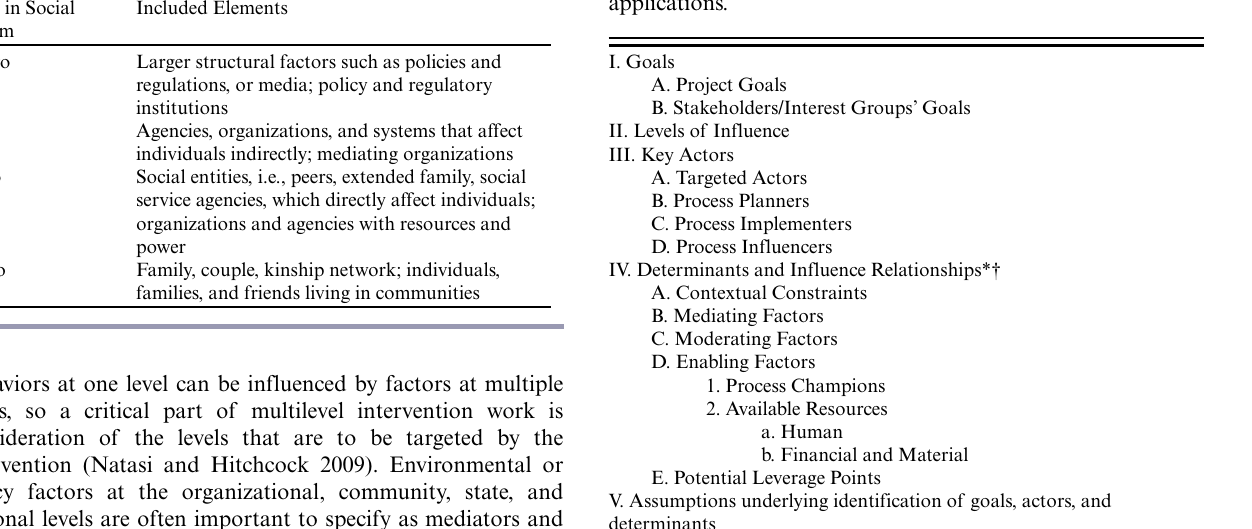
Table 2 . Elements within the organizational structure of behavior- based intervention design for exploratory problem assessment (Beratan 2019) and other collaborative adaptive management